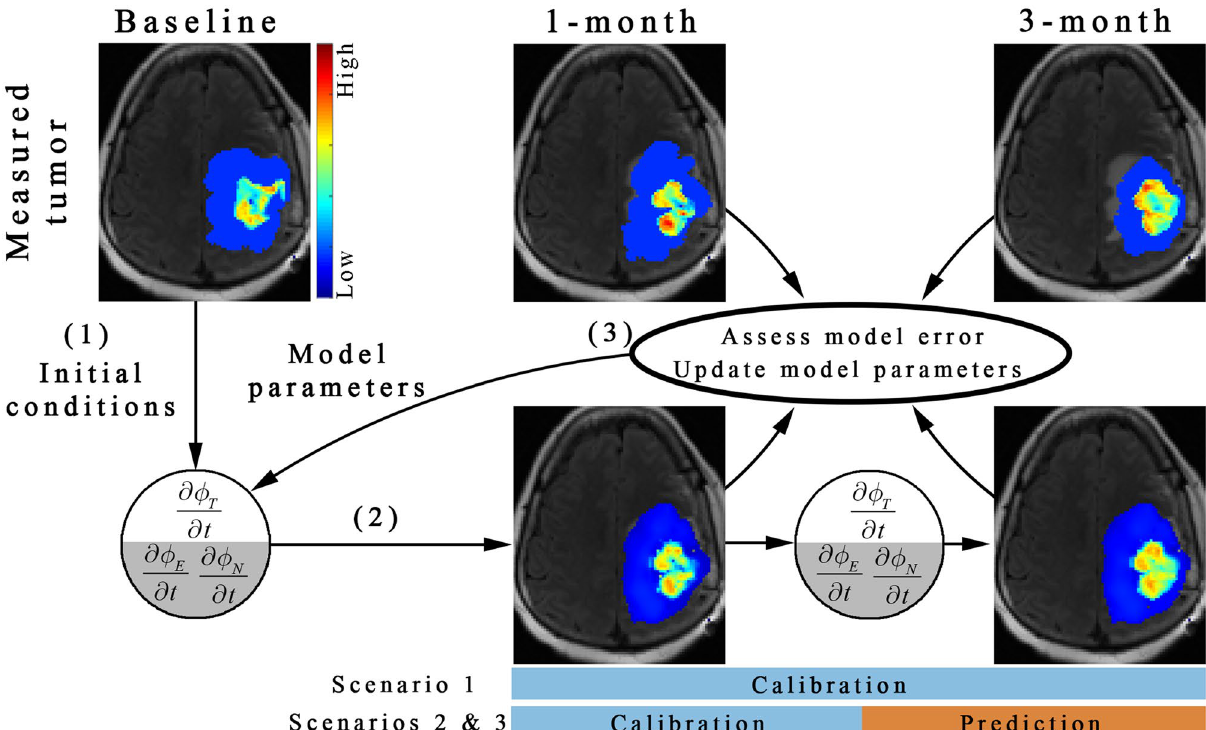
Figure 2. Schematic of the model calibration and prediction framework. The central slice from patient 1 is used to illustrate the model calibration and prediction framework. First, the baseline tumor distribution and an initial guess of model parameters are used in a forward run of the of either the single species ( ( E and N ) model to estimate the spatial distribution of tumor cells. Second, the predicted tumor distribution is sampled at the 1-month and 3-month time points. Third, the error between the measured and the model ϕ ϕ predicted tumor distribution is computed and then used to update model parameters (using the Levenberg– Marquardt approach). This model calibration process continues until stopping criterion are met (e.g., iteration count, or convergence of objective function). For scenario 1, all available imaging time points (i.e., 1-month and 3-month for patient 1) are used to calibrate the model parameters. For scenarios 2 and 3, a subset of the imaging time points (e.g., only 1-month) are used to calibrate model parameters leaving the remaining imaging time points to evaluate prediction accuracy. MATLAB R2019b (Mathworks, Natick, MA) was used for producing individual figures, images, and graphs. Adobe Photoshop 2020 (Adobe, San Jose, CA) was used to arrange individual panels, draw schematics, and add